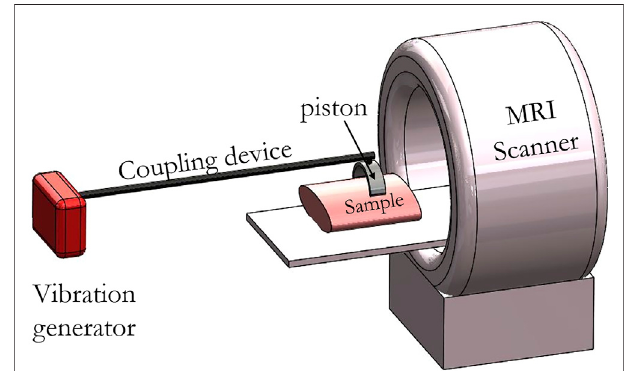
FIGURE 1 | Schematic representation of an MRE mechanical actuator positioned within the MRI machine. Generated waves are transmitted to the sampleviathecouplingdeviceandapiston.Couplingdevicesandpistonsare made of an MRI-compatible material such as plastic or PEEK for examplewhichallowspositioninginsidetheMRIscanner.Pistonscaneither fi t the form of the sample, be rigid or be invasive in case of a needle. Coupling devices can be either fl exible or rigid depending on the chosen material. Vibration generators are generally incompatible for usage close to an MRI scanner and have to be placed outside of the